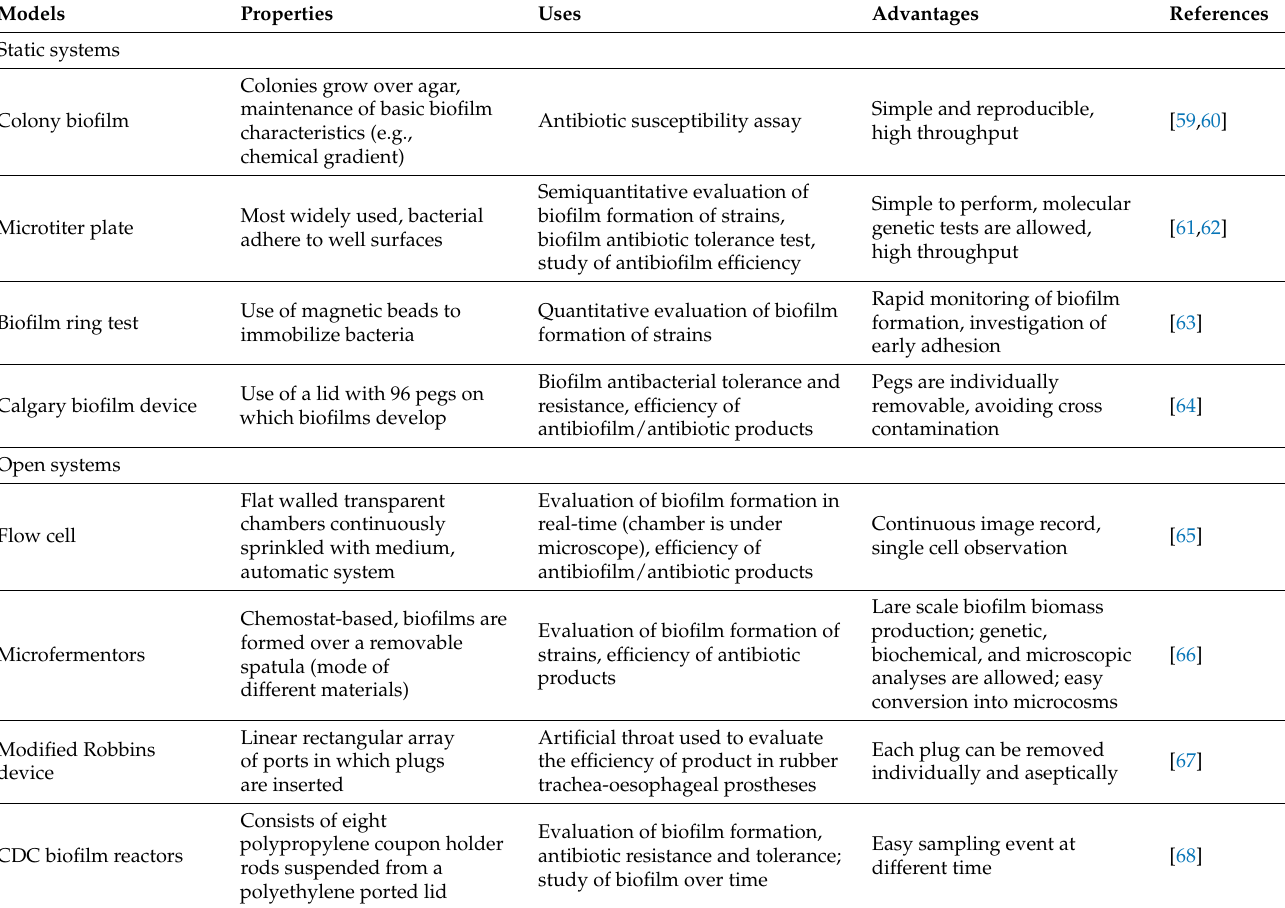
Table 1. This table briefly presents the three different methods to study biofilms, with some extra details of properties, field of application, and